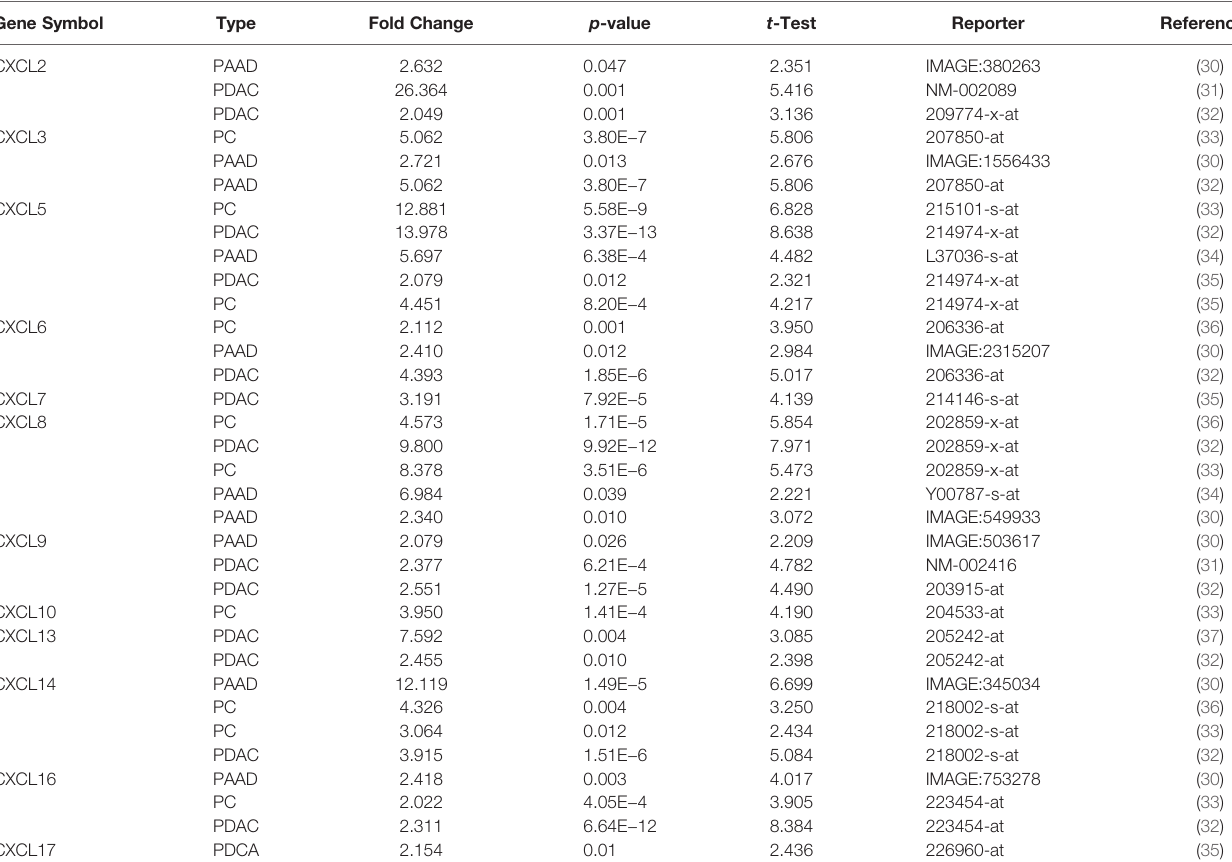
TABLE 1 | The transcriptional levels of abnormal expression CXC chemokines in different types of pancreatic cancer tissues